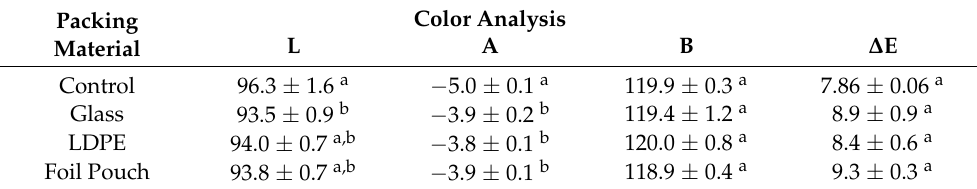
Table 4. UV radiation effect on the CIElab parameters of turmeric